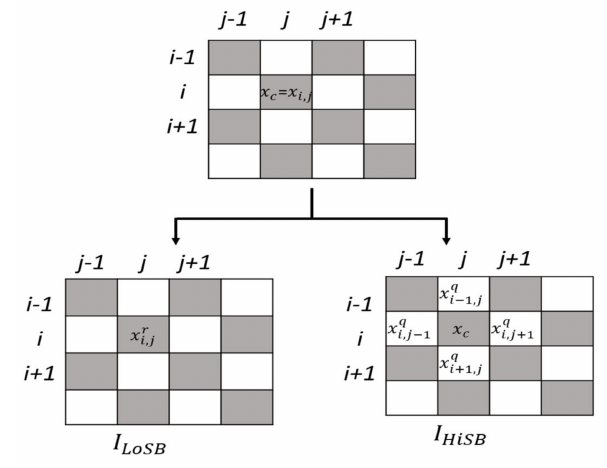
Figure 5. Image I is divided into I HiSB and I LoSB